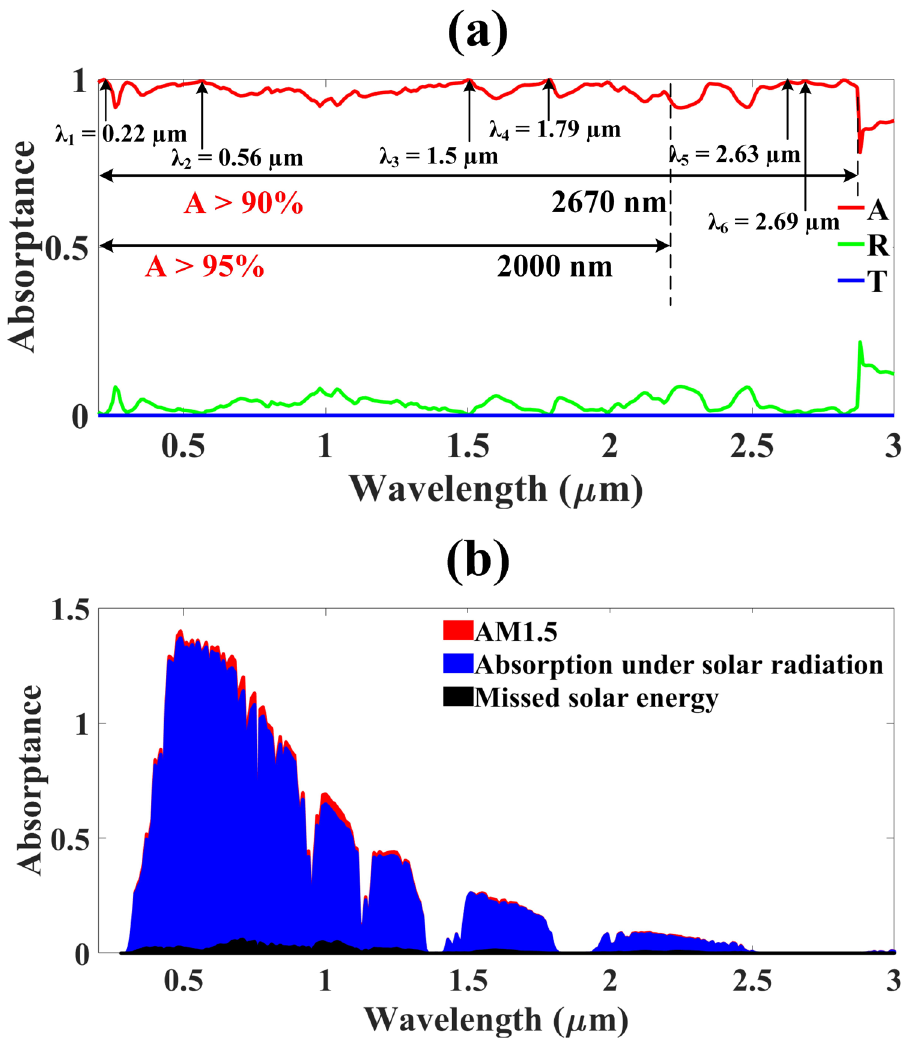
Figure 3. absorption response of the developed UWBSEA ( a ), absorption, reflectance, and transmittance response of the developed UWBSEA, average absorption above 90% is attained for the UWB range of 2670 nm and the average absorption above 95% is observed for the UWB range of 2000 nm with the six near perfect absorption peaks, ( b ) absorption under solar AM1.5 conditions. A very small amount of solar energy is being missed by the developed UWBSEA in the visible range otherwise almost identical absorption is